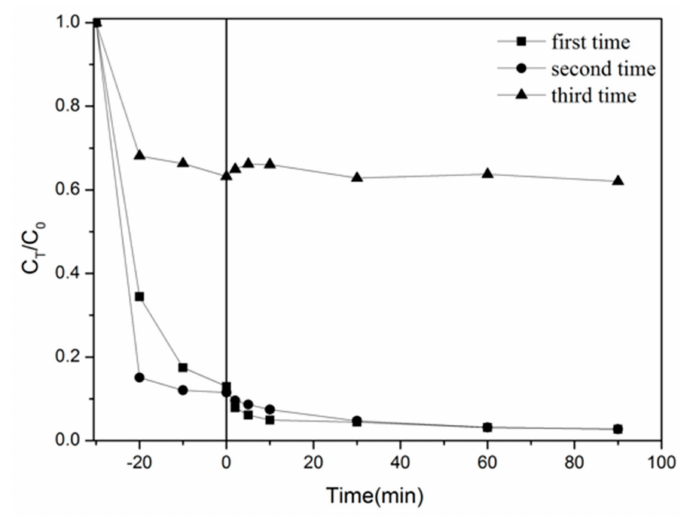
Figure 6. Repeated adsorption and photocatalytic degradation of SMX under visible light by Ag@Ag 2 O-G2 (C catalyst = 0.25 g/L, C SMX = 2.5 mg/L).